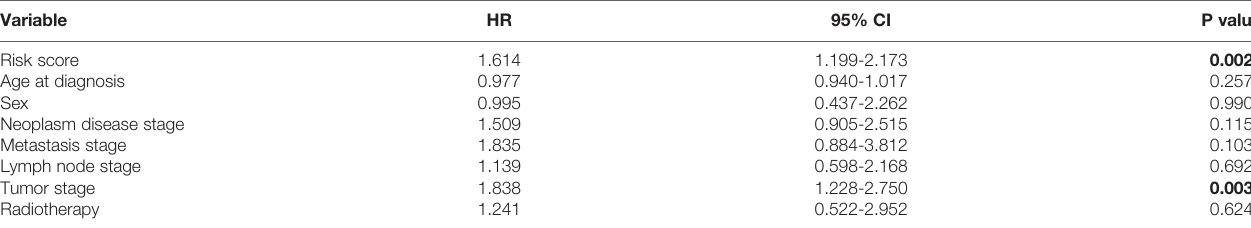
TABLE 2 | Multivariate analysis of progression-free survival in the BRAF-mutant PTC cohort. Variable Risk score